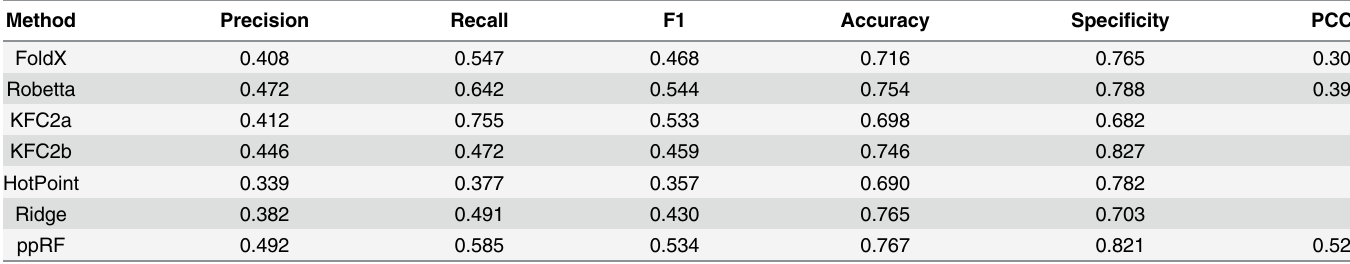
Table 4. Performance comparison between FoldX, Robetta, KFC2, HotPoint and ppRF on the SKEMPI dataset. FoldX, Robetta, Ridge and ppRF are able to produce numerical values of ΔΔ G p . A predicted binding hot spot for these three methods is defined using ΔΔ G p (cid:1) 1.5. ‘ Ridge ’ indicates the prediction results of Ridge regression on our feature space used for ppRF, and ‘ PCC ’ denotes Pearson correlation coefficients between the predicted ΔΔ G and experi- mental ΔΔ G . Method